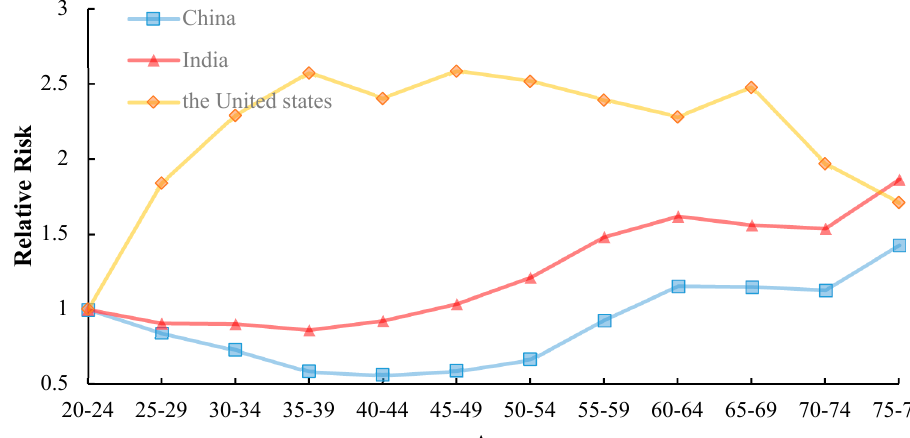
Figure 6. Age effects on TB incidence rate for China, India, United States, from 1992 to 2017. Figure 6. Age e ff ects on TB incidence rate for China, India, United States, from 1992 to